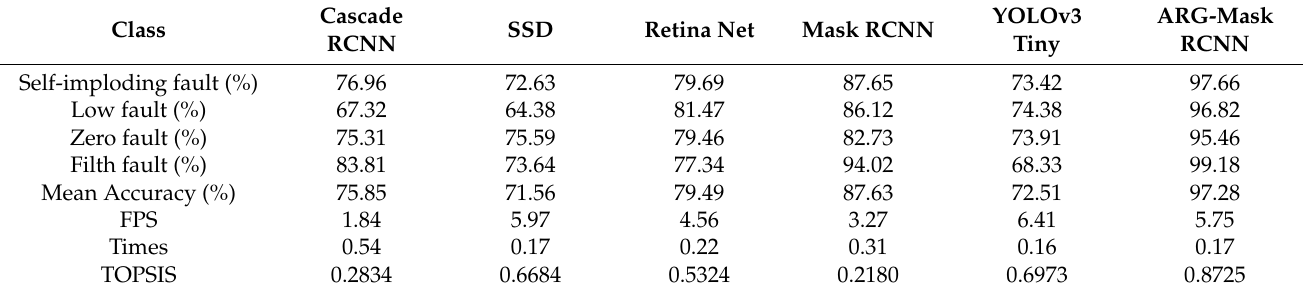
Table 4. Six different methods for accuracy and TOPSIS